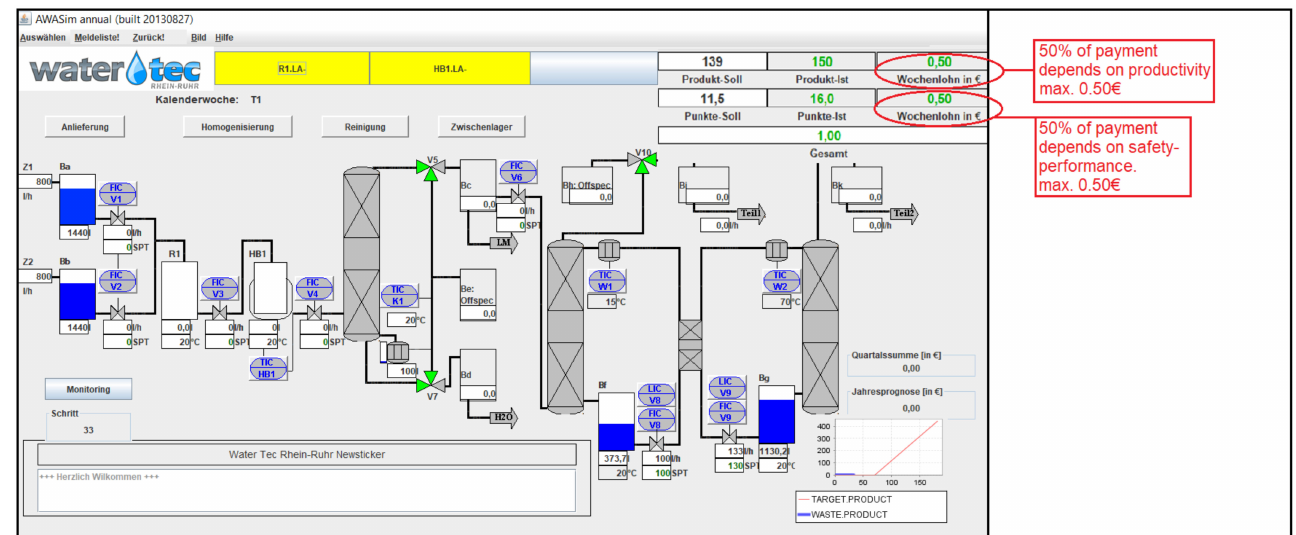
Figure 1. WaTrSim interface, highlighting pay